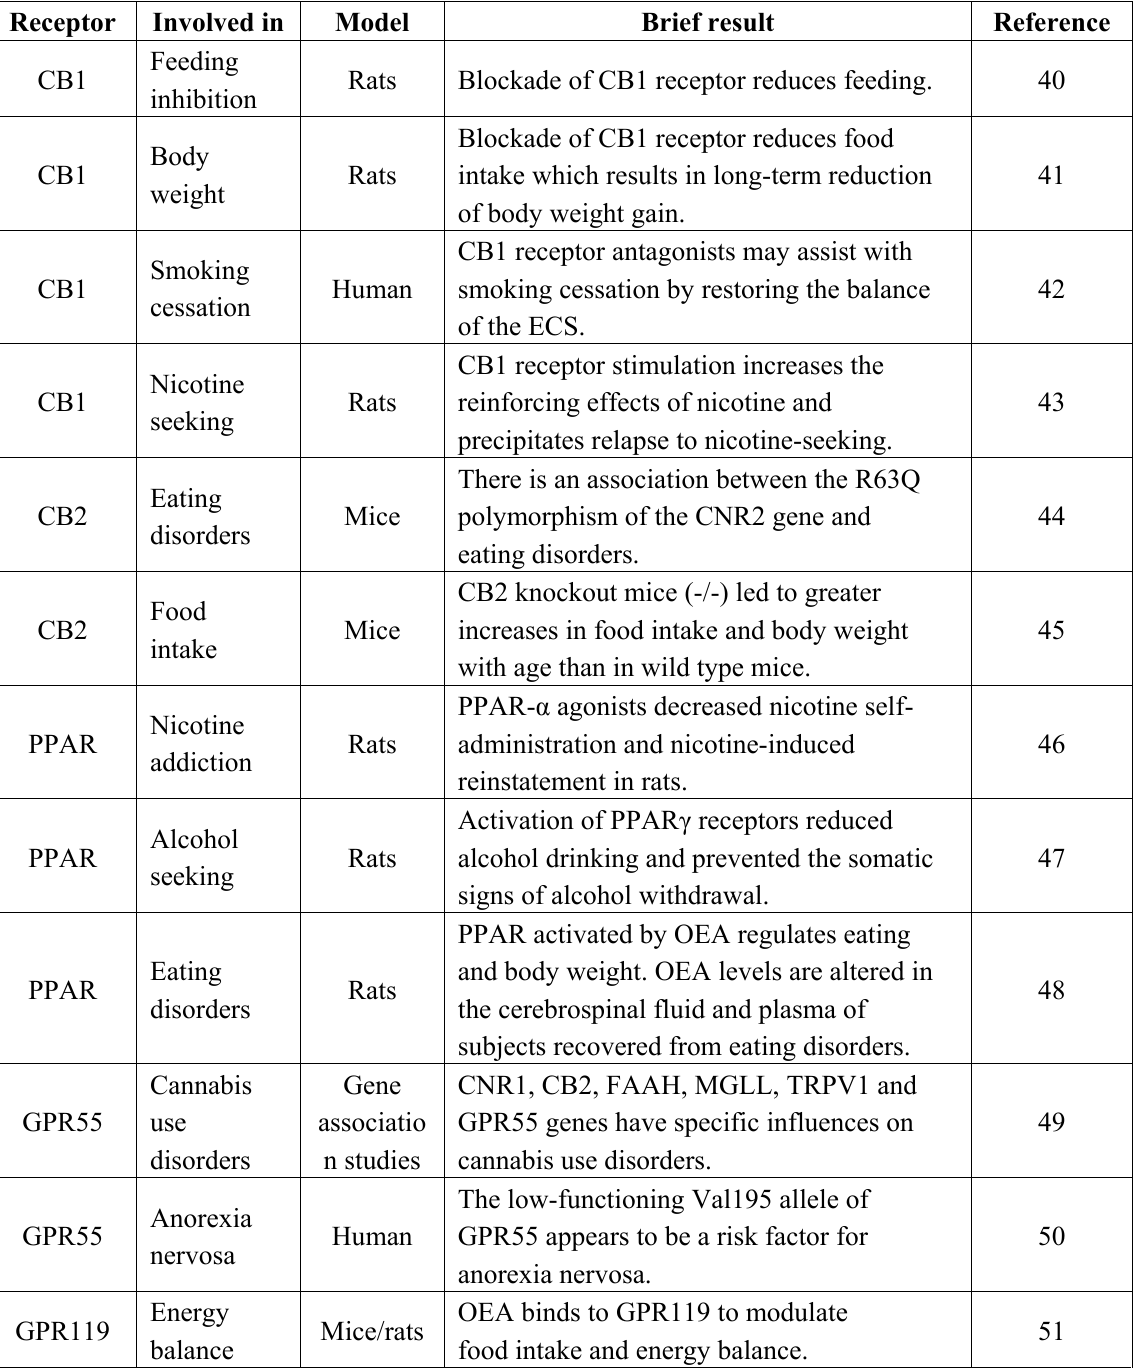
compounds, in relevant aspects covered in this